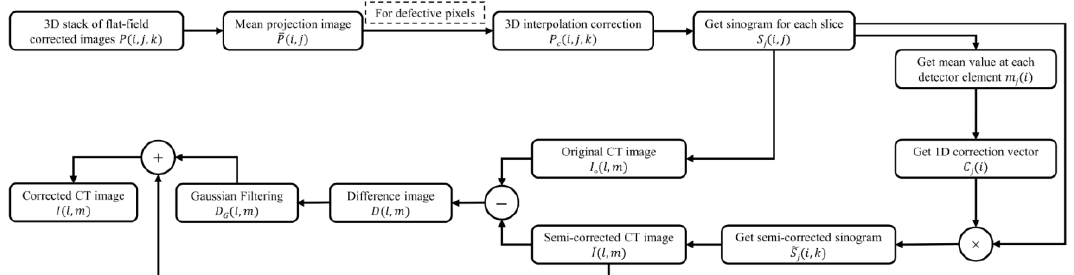
Figure 5. The procedures of the ring artifact correction.